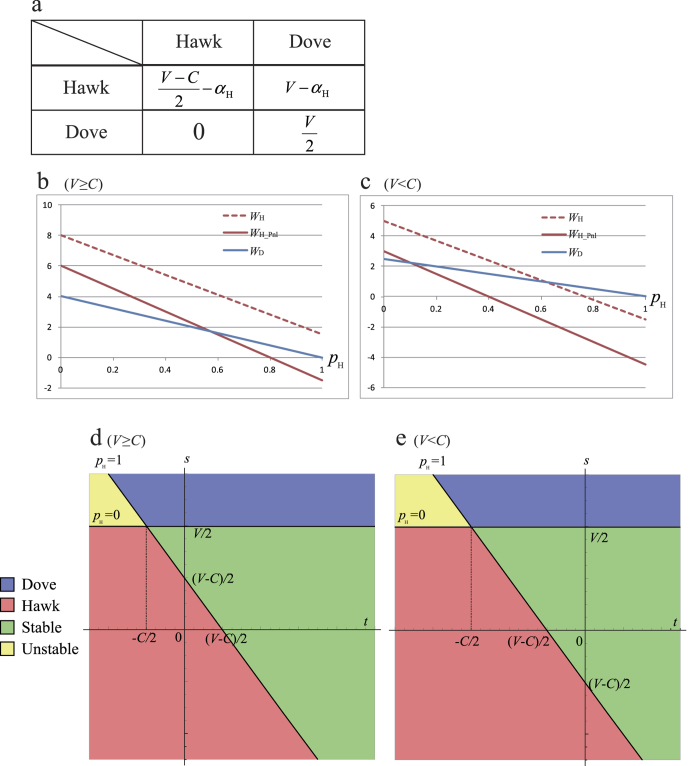
Social penalty introduced into the hawk-dove game.(a) Payoff matrix of a hawk-dove game include social penalty αH. (b,c) The average payoffs (W) of hawk and dove. Values of WH (p), WH_Pnl (p), and WD (p) are plotted against the frequency p of hawk. The intersections determine indicates a stable mixed strategy ESS (t = 1, s = 2). (b,d) Fighting between hawk is mild; that is, V ≥ C (V = 8, C = 5); (c,e) Fighting is severe, V < C (V = 5, C = 8). (d,e) The phase diagram of t and s. Outcomes depend on penalty parameters: pure Dove (blue), pure Hawk (Red), stable mixed strategy ESS (Green), and non-ESS Nash equilibrium (Yellow).